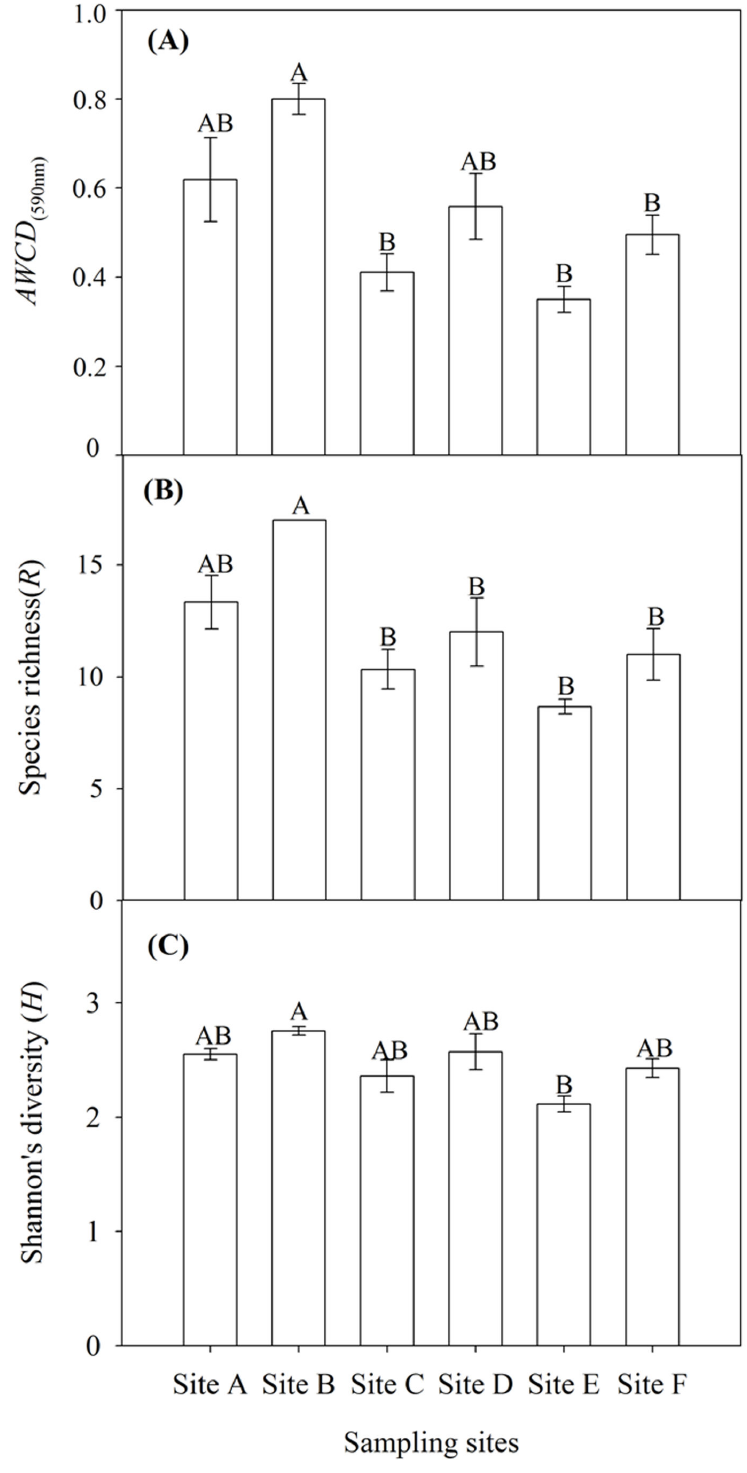
Figure 2. Functional diversity index of sediment bacterial community. (A) AWCD Shannon’s diversity ( H ) of bacterial community in the sediments from each six sampling sites (site A, site B, site C, site D, site E, site F) in the Zhou cun drinking water reservoir, eastern China. Bars followed by the same capital letter indicate no significant difference by Tukey-Kramer HSD ( P <0.05). The data shown are the means and standard error (S.E) ( n =3). doi: 10.1371/journal.pone.0078571.g002 PLOS ONE |